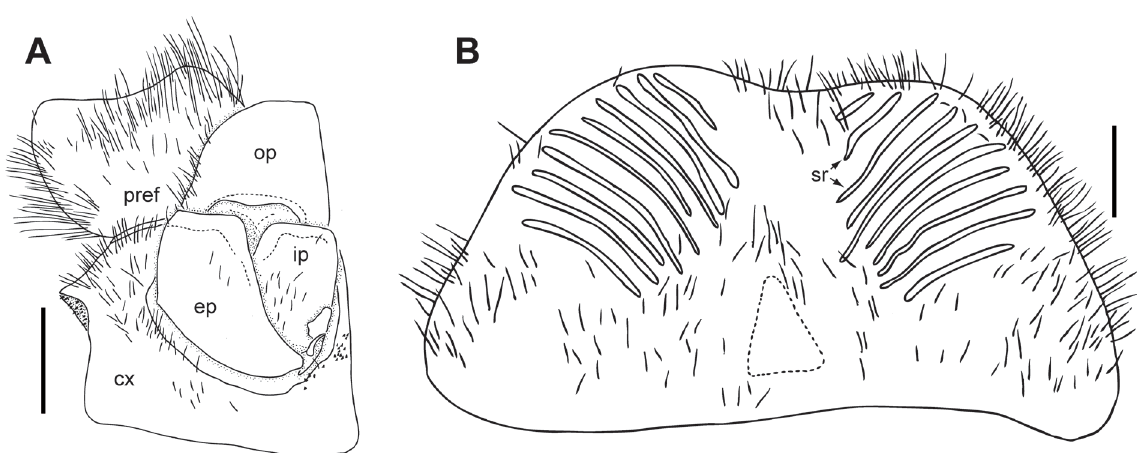
Fig. 6. Sphaeromimus kalambatritra sp. nov., schematic drawing, ♀, paratype ( CASENT 9058301). A . Left vulva (2 nd coxa). B . Subanal plate. Abbreviations: cx = coxa; ep = exterior plate; ip = interior plate; op = operculum; pref = prefemur; sr = stridulation ribs. Scale bars =